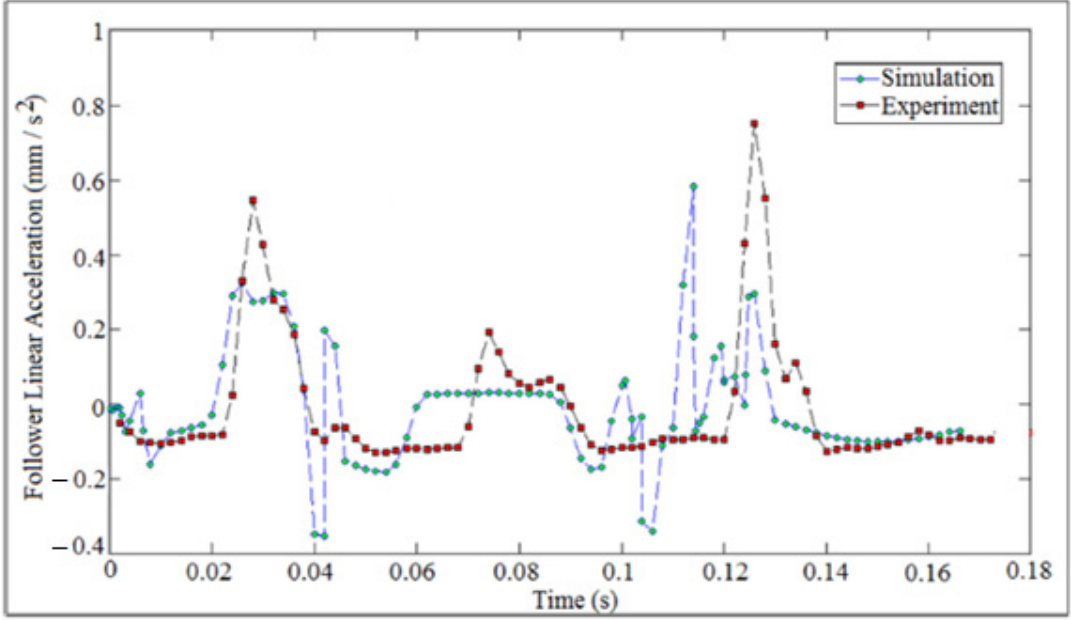
Figure 40. Comparison of follower linear acceleration against time.